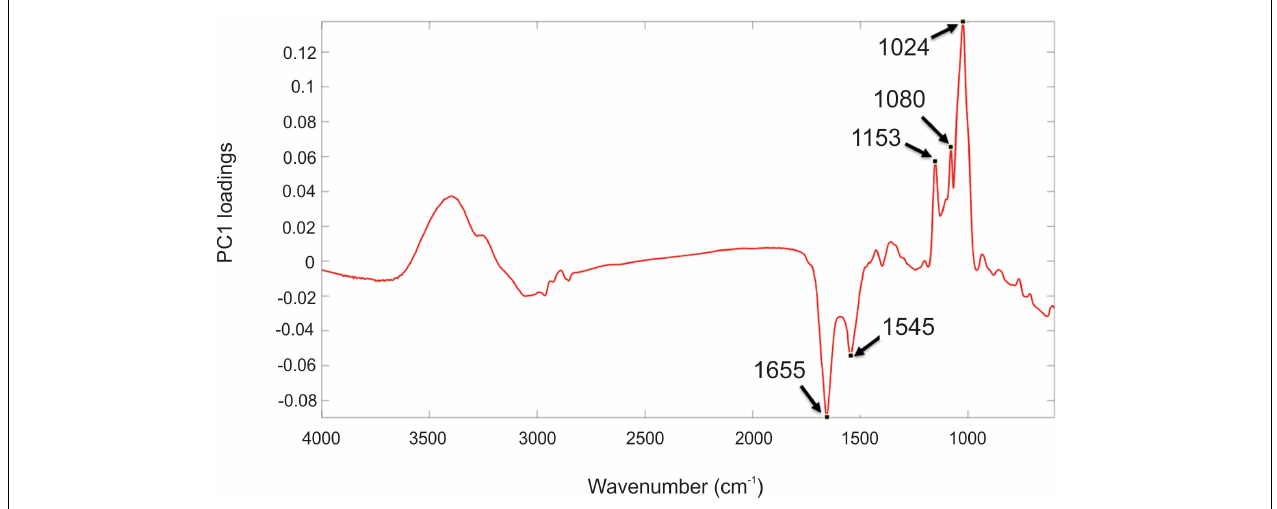
FIGURE 3 | PC1 loading plot including the wavenumbers contributing to the shifts seen across PC1. Spectral features highlighted refer to the following: 1655 cm - 1 (amide I); 1545 cm - 1 (amide II); 900–1200 cm - 1 (carbohydrates).